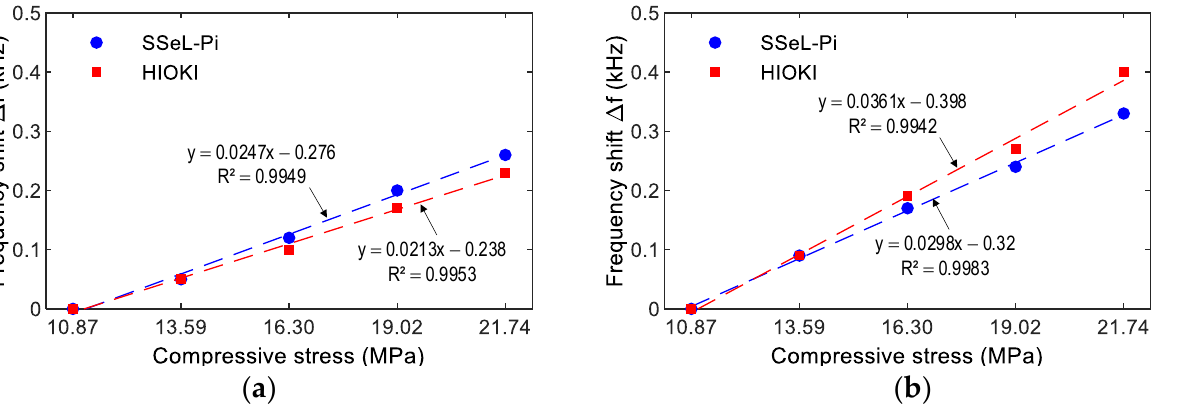
Figure 25. Relationship between frequency shift and corresponding compressive stress. ( a ) PZT1,